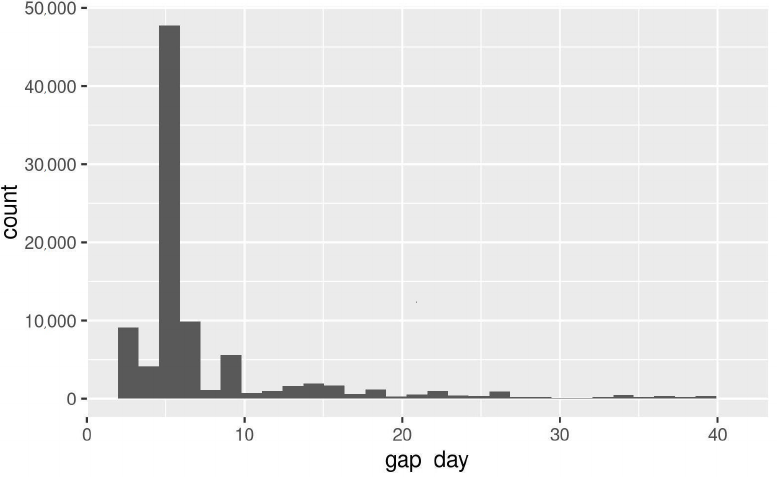
Figure 4. A histogram of the temporal gap between SMART tuples by